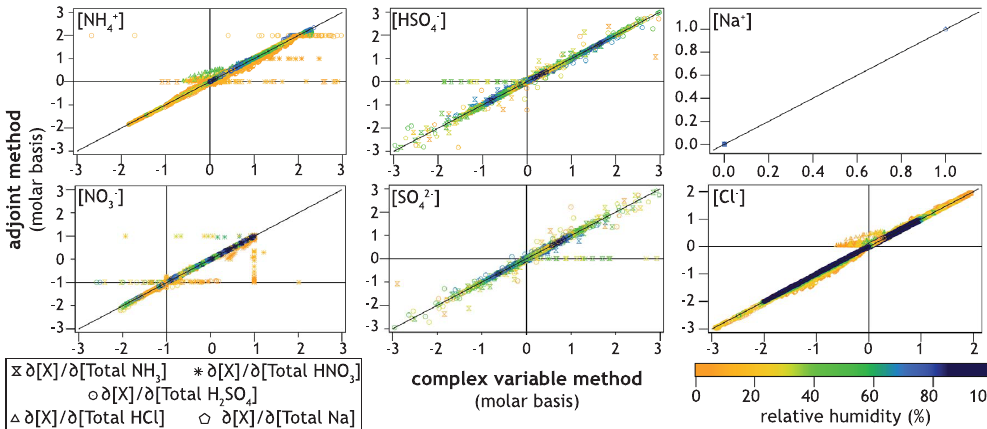
Fig. 4. The sensitivities of aqueous species with respect to the total amount of each aerosol species on a molar basis from ANISORROPIA are shown against those from CVM for the range of aerosol precursor concentrations, temperature, and RH outlined in the text (Sect. 3).